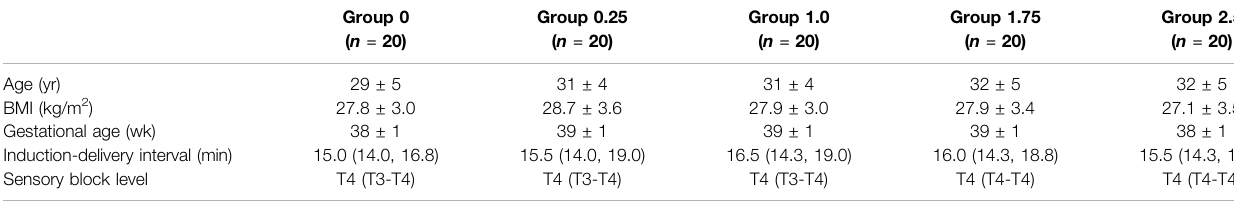
TABLE 1 | Demographic data, surgical times and sensory block level.